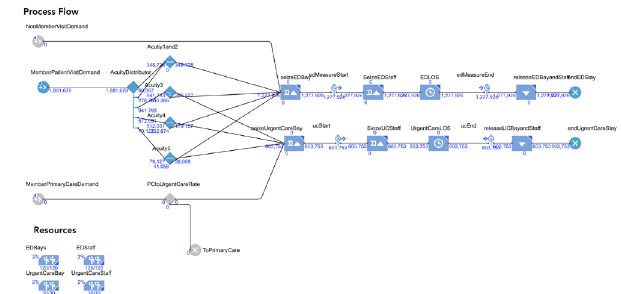
Figure 2. Discrete event approach. Source: AnyLogic®.